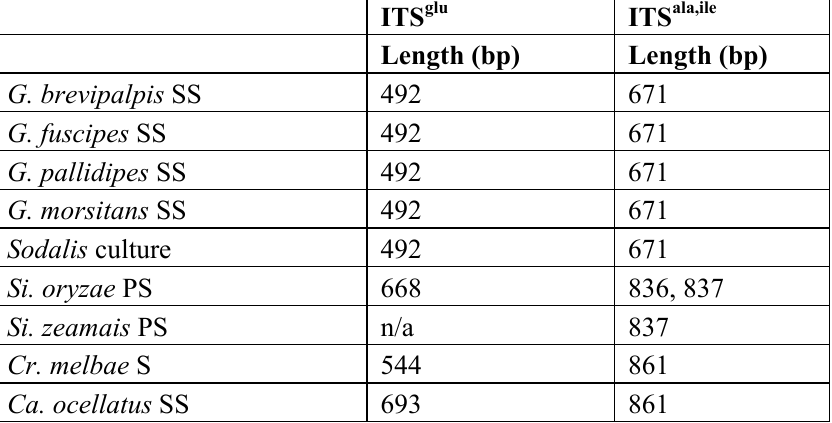
Table 1. Comparison of the ITS glu and ITS ala,ile lengths for Sodalis and allied symbionts. With the exception of Sodalis from culture, host species are